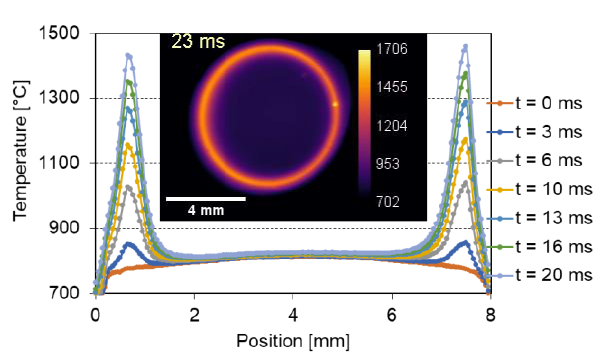
Fig. 7. Measured temperature at the surface of a UO 2 sample submitted to 300W annular beam irradiation during 20ms on both sides. Image: thermal camera snapshot at the end of the laser pulse ; Data plot: extraction of the temperature along vertical profile of the thermal images at different times.